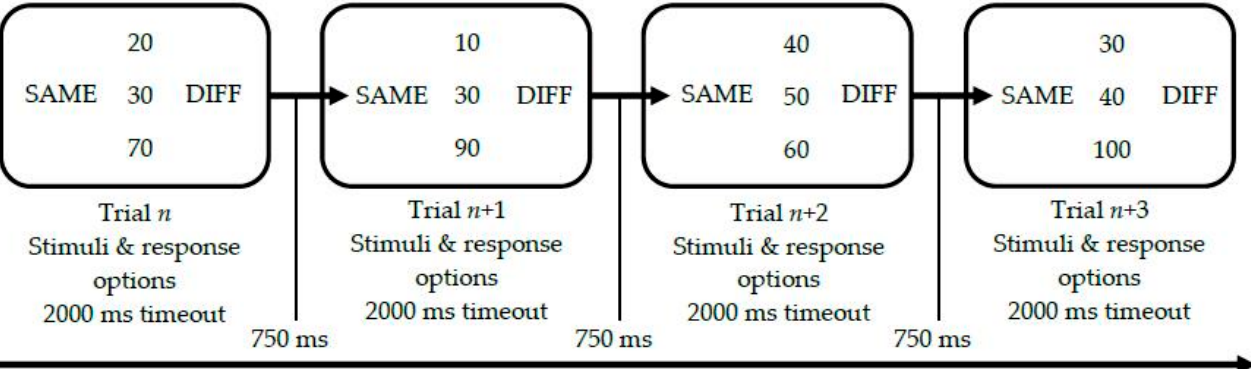
Figure 5. Trial design for condition 3b (unrelated task with simultaneous FL exposure).